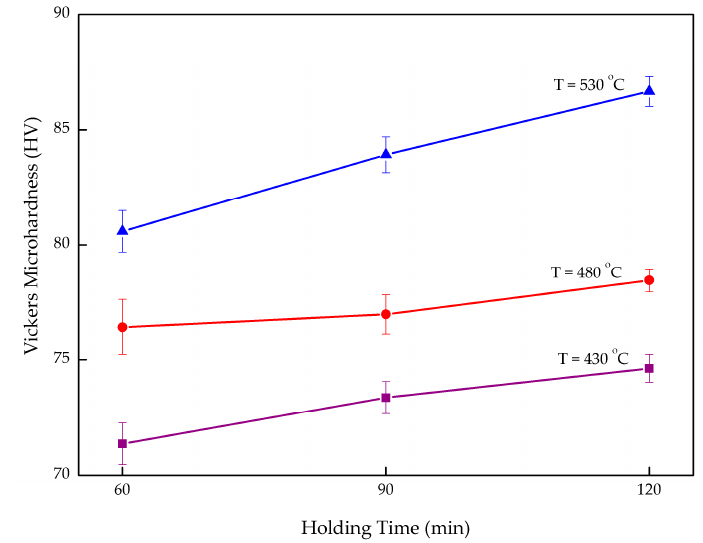
Figure 3. Microhardness responses in relation to different temperature and holding times.